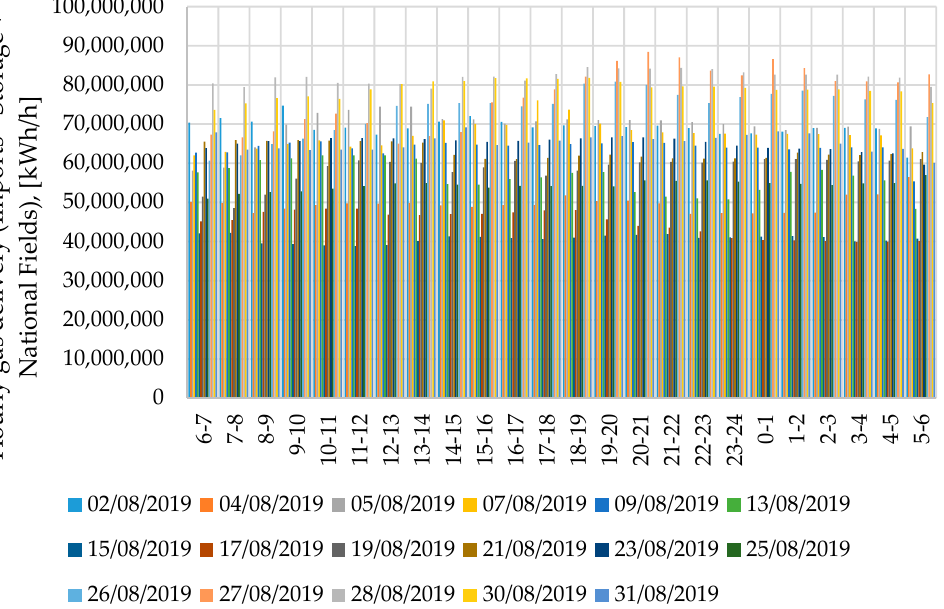
Figure 5. Hourly gas delivery for the 17 days analyzed in August 2019. Data from [45].